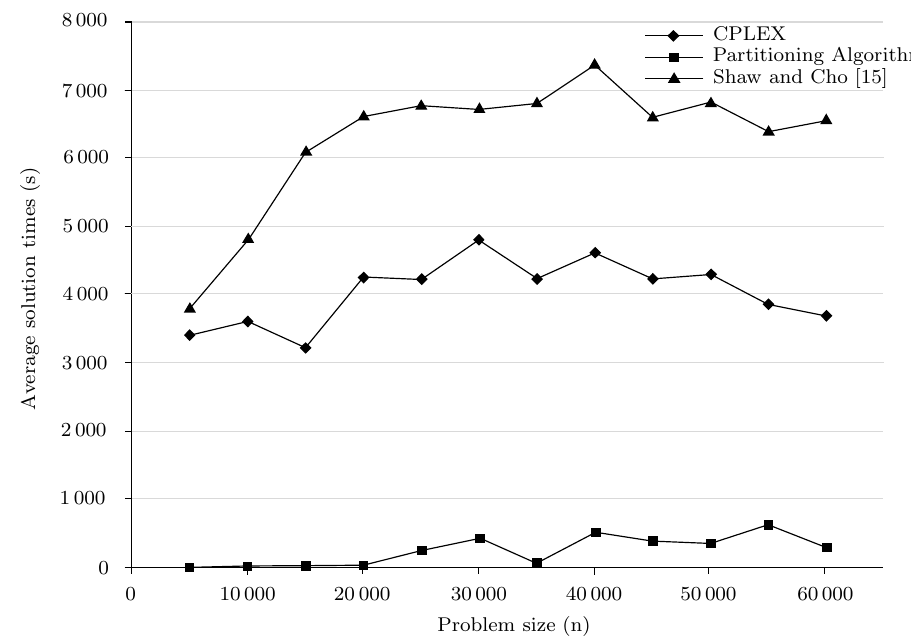
Figure 3: Average solution times for the strongly correlated TKP data class.